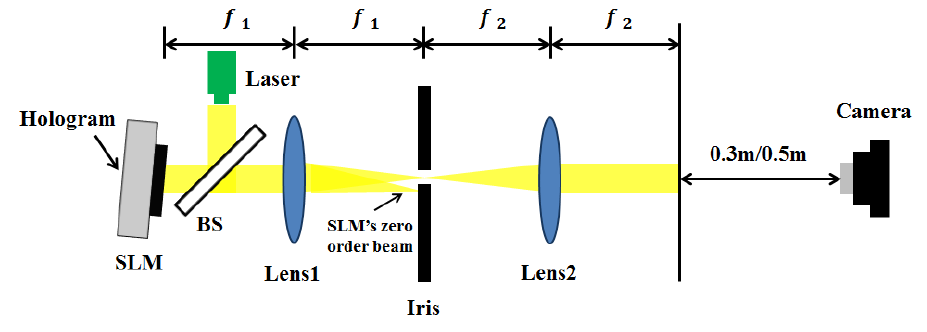
Figure 9. Optical setup for hologram reconstruction experiment.